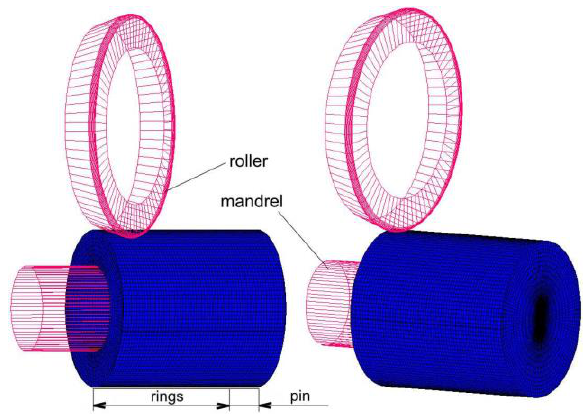
Figure 8. Numerical model of roller burnishing.